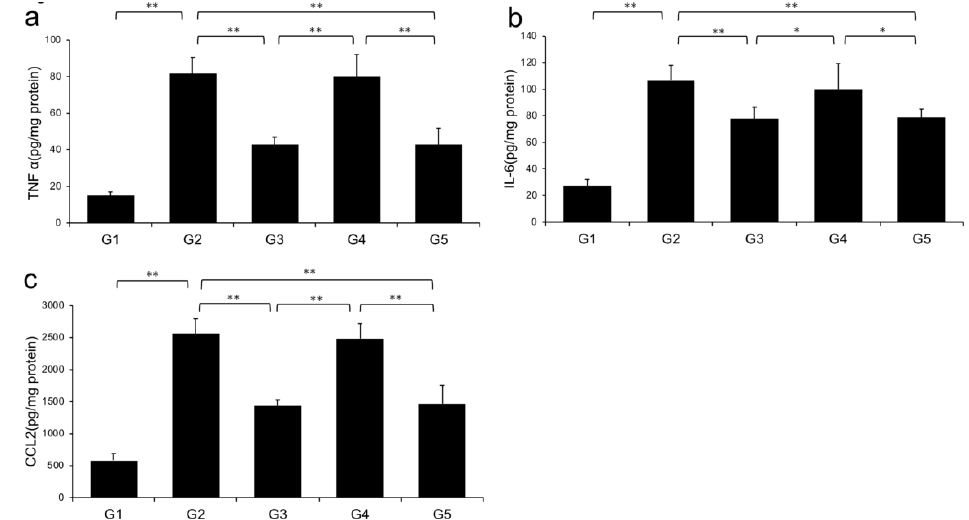
Figure 5. Effects of canagliflozin (CA) and teneligliptin (TE) on hepatic inflammatory cytokines; ( A ) tumor necrosis factor- α ( B ) Interleukin-6 ( C ) C-C motif chemokine 2. G1, Group 1